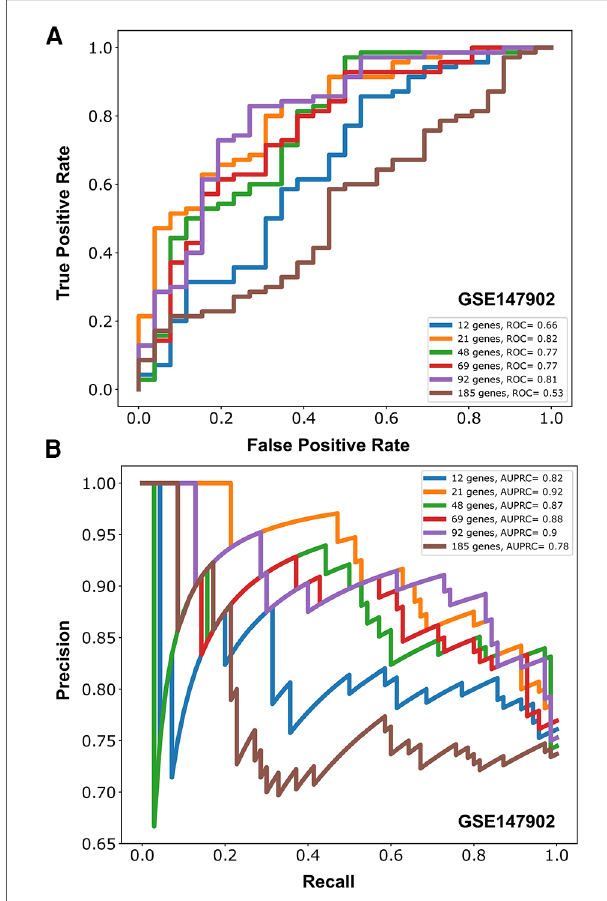
FIGURE 3 Area under the receiver operative curve (AUROC) ( A ) and area under the precision recall curve (AUPRC) ( B ) for different number of genes (12, 21, 48, 69, 92, 185) selected to model moderate/severe pediatric acute respiratory distress syndrome (ARDS; P a O 2 /F i O 2 <200) vs. mild pediatric ARDS (P a O 2 /F i O 2 =200 – 300) from GSE147902.